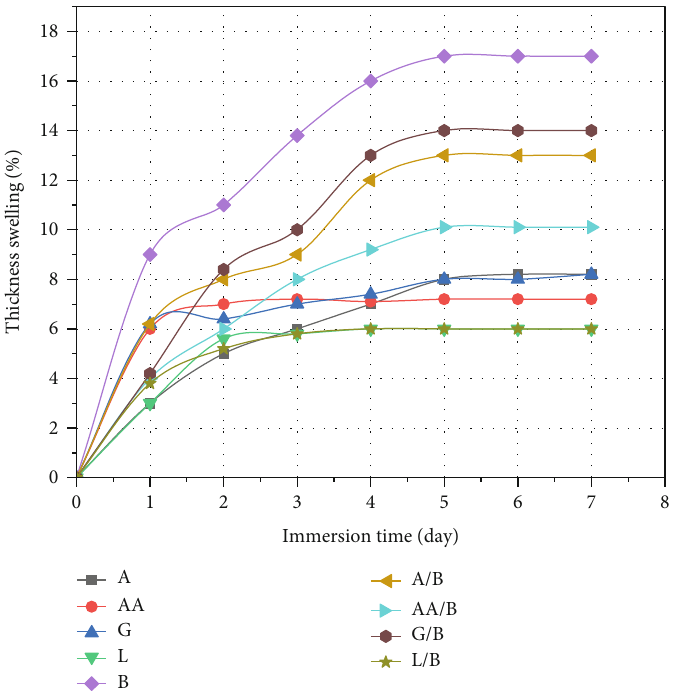
Figure 3: Thickness swelling for DPF and hybrid